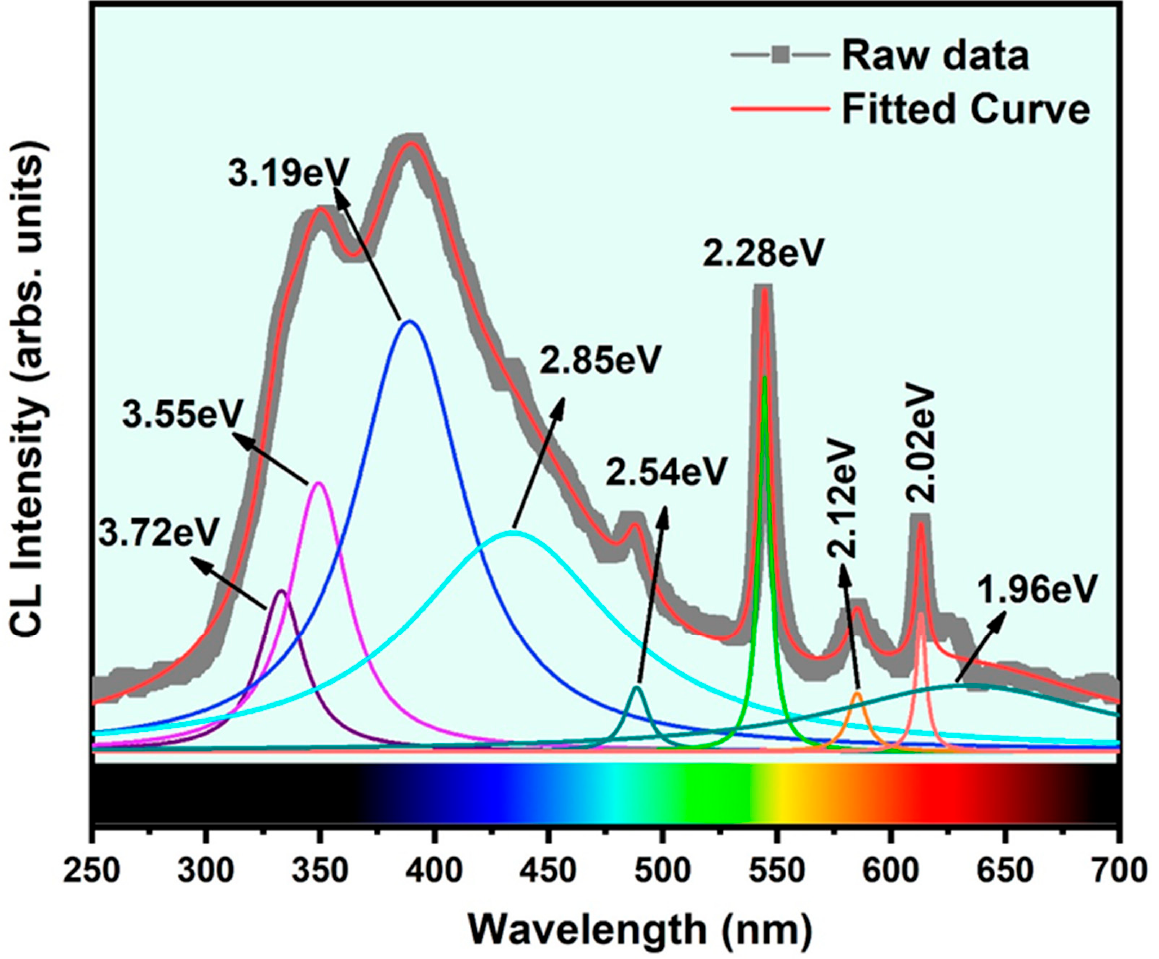
Figure 5. RT-cathodoluminescence spectrum recorded from the β -Ga 2 O 3 nanowires grown on Si (100) substrate.